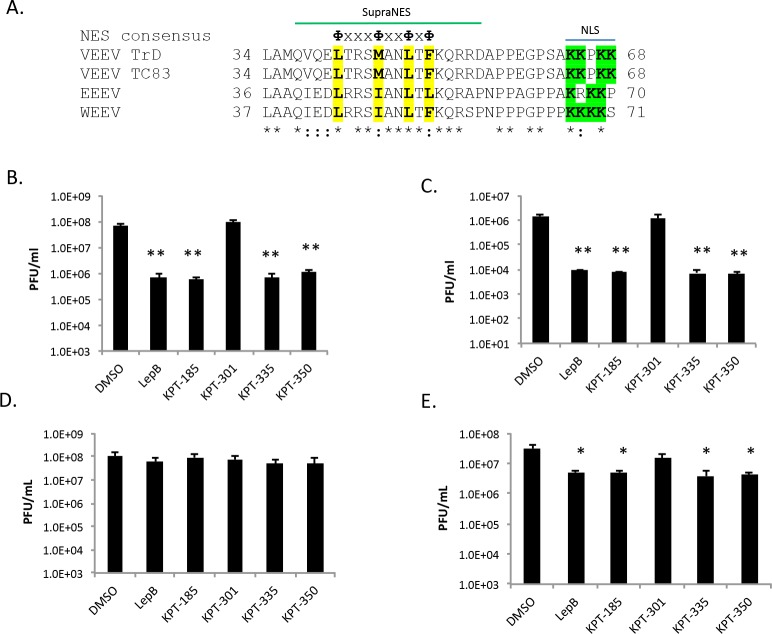
SINE compounds inhibited New World alphaviruses more dramatically than Old World alphaviruses.(A) Capsid alignment using Uniprot. Asterisks indicate positions which have a fully conserved residue. Colons indicate conservation between amino acids of strongly similar properties. Periods indicate conservation between amino acids of weakly similar properties. Residues within the consensus NES sequence (ФxxxФxxФxФ, where Ф = L, I, F, V or M and x = any amino acid) are highlighted in yellow. Positively charged residues within the NLS are highlighted in green. The supraNES sequence identified in VEEV capsid is indicated [17]. Conservation among different strains of the four viruses aligned—VEEV-TrD (GenBank Accession Number AAB0251), VEEV-TC83 (CAA27883), EEEV-82V-2137 (CAA29261), and WEEV-BFS1703 (AAA42999)–was strong for the sequence examined. (B) Vero cells were treated for two hours prior to infection with DMSO (0.5%), 45 nM Leptomycin B, or 2.5 μM of KPT-185, KPT-301, KPT-335, or KPT-350. After an hour infection with EEEV (GA97) (MOI 1), the cells were post-treated with inhibitors. At 16 hpi, supernatants were collected and plaque assays performed using Vero cells. Graphs represent biological triplicates and each experiment was performed twice. (C) Vero cells were treated as described above, infected with WEEV (California 1930) (MOI 1), and titered by plaque assay in Vero cells. (D) Vero cells were treated as described above, infected with SINV (EgAr 339) (MOI 1), and plaque assays were performed using BHK-21 cells. (E) Vero cells were treated as described above, infected with CHIKV (S27) (MOI 1), and plaque assays were performed using BHK-21 cells. *p-value ≤ 0.001, **p-value ≤ 0.005 (compared to DMSO treated cells at the corresponding time point).